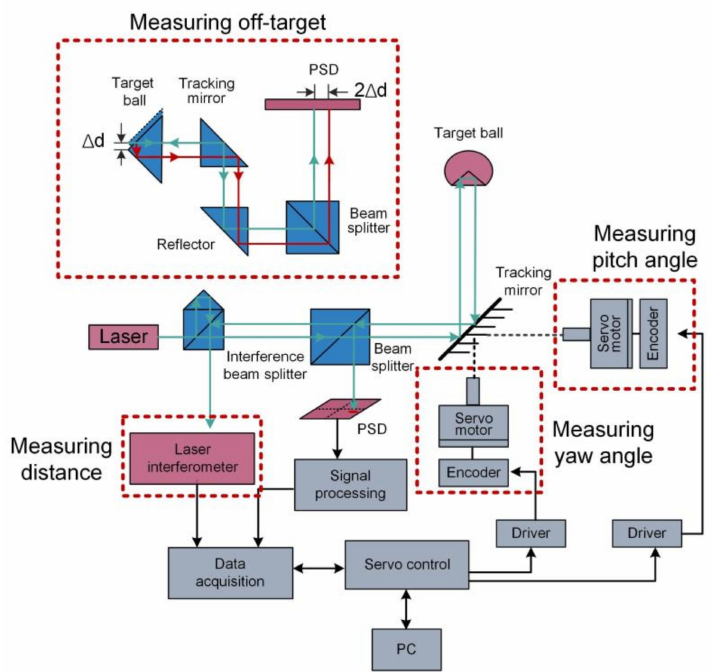
Figure 2. System diagram of a laser tracker and the principle of measuring the miss distance. In recent years, many researchers have turned to PSD for miss distance measure- ment. The detection results of PSD are independent of spot size and spot mode because it directly detects the center of gravity of spot intensity. Additionally, the FOV of PSD is wider than QD since PSD can achieve continuous detection of the spot over the entire photosensitive